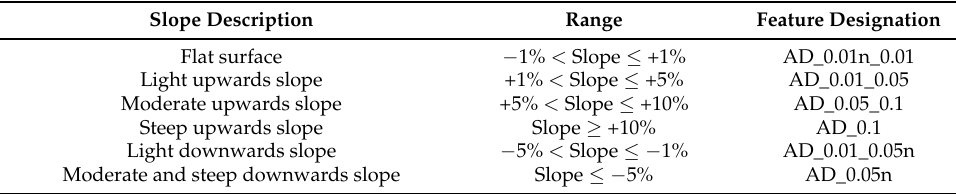
Figure 6. Example of the altimetric profile of a trip as measured by the sensorized truck. Table 4. Considered slope ranges and description.